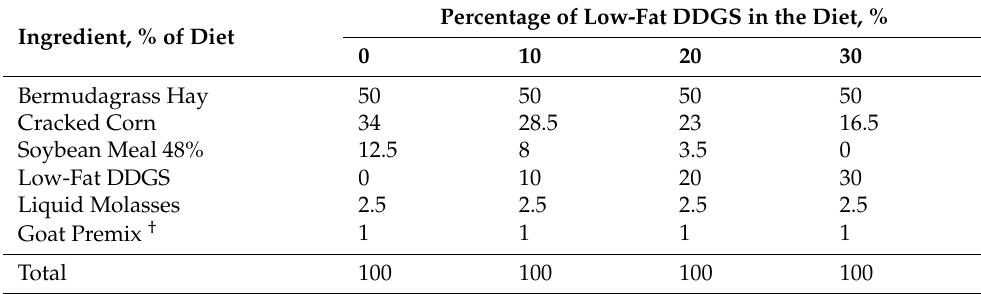
Table 1. Composition of experimental diets containing varying levels of low-fat distillers dried grains with solubles (LF-DDGS) and hay used for 84 day feeding period (on an as-fed basis). Percentage of Low-Fat DDGS in the Diet, % Ingredient, % of Diet 0 10 20 30 Bermudagrass Hay 50 50 50 50 Cracked Corn 34 28.5 23 16.5 Soybean Meal 48% 12.5 8 3.5 0 Low-Fat DDGS 0 10 20 30 Liquid Molasses 2.5 2.5 2.5 2.5 Goat Premix † 1 1 1 1 Total 100 100 100